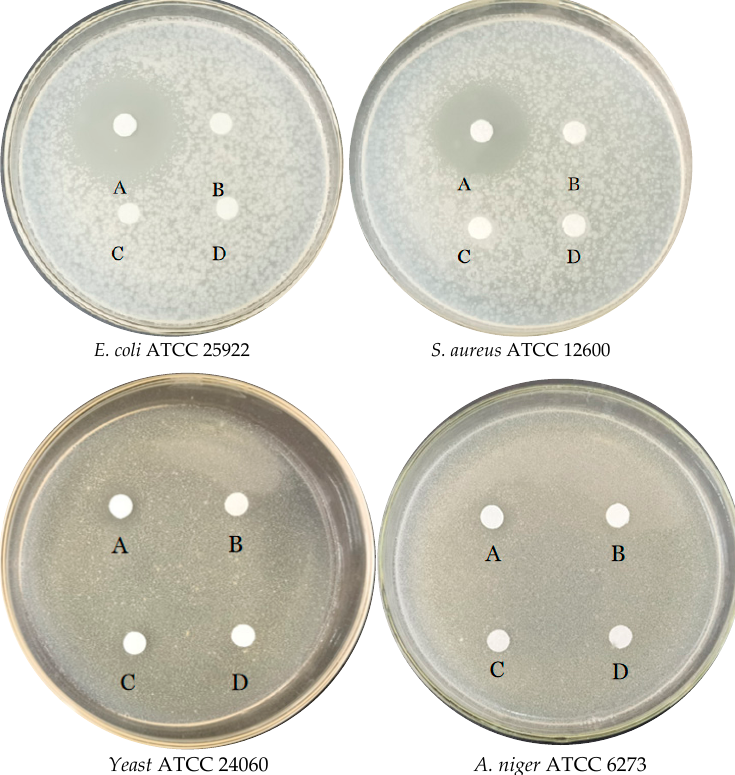
Figure 4. Antimicrobial activity of E. faecium FUA027 against quality control strains. The upper organic phase of E. faecium FUA027 fermentation liquid after extraction with ethyl acetate (concentrated five times) (A), the lower aqueous phase of E. faecium FUA027 after extraction with ethyl acetate (B), ABB medium extracts (C), and ethyl acetate (D).